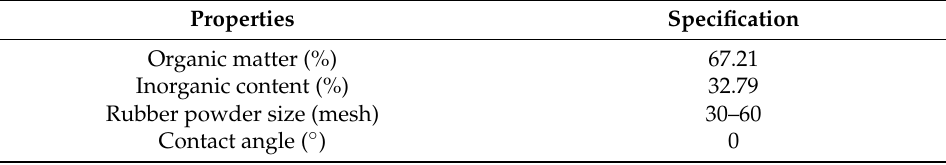
Table 2. Technical characteristics of rubber powder.